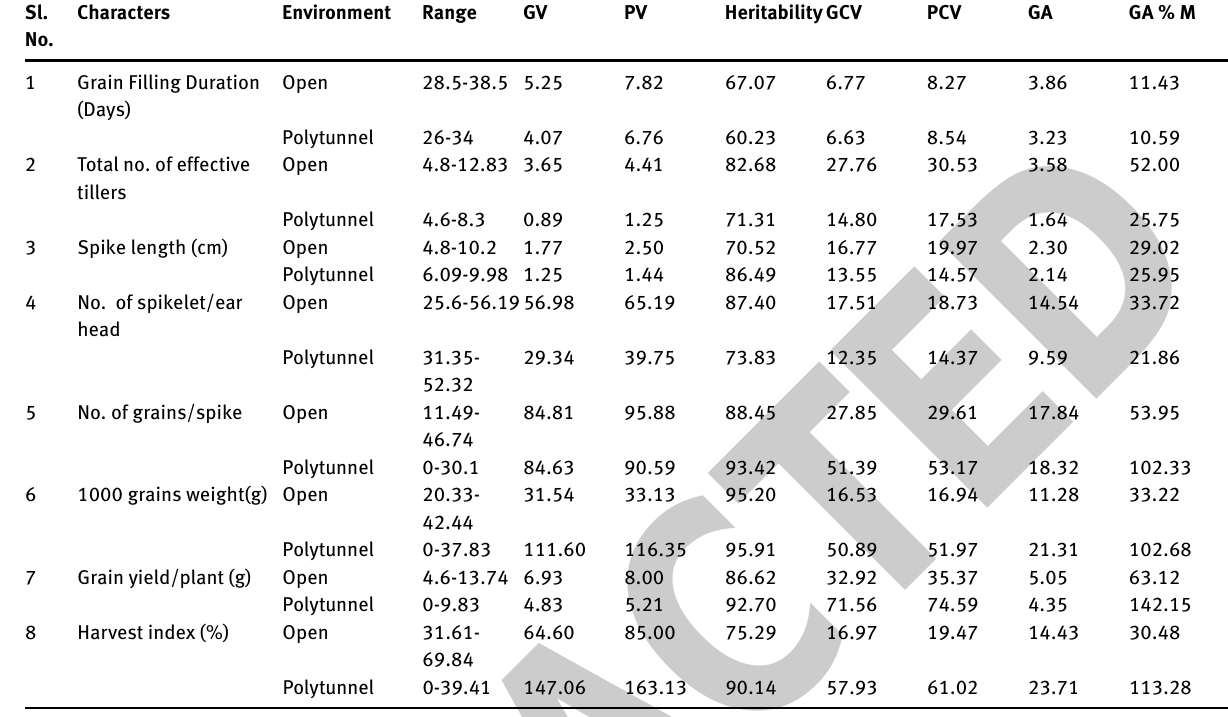
Table 4: Estimates of genotypic variance, phenotypic variance, heritability, genetic advance, genetic advance as per cent of mean, genotypic (GCV) and phenotypic coefficient of variation (PCV) Sl.